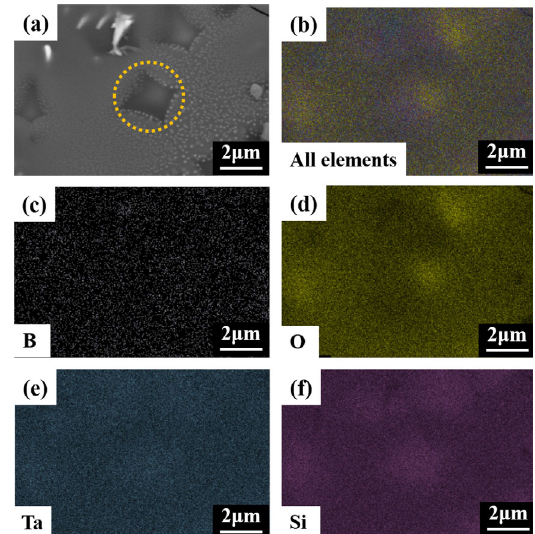
Fig. 15 Surface EDS spectrum of the 40wt%TaB 2 – 40wt%MoSi 2 –SiC/SiC coating surface after isothermal oxidation test at 1500 ℃ for 100 h.